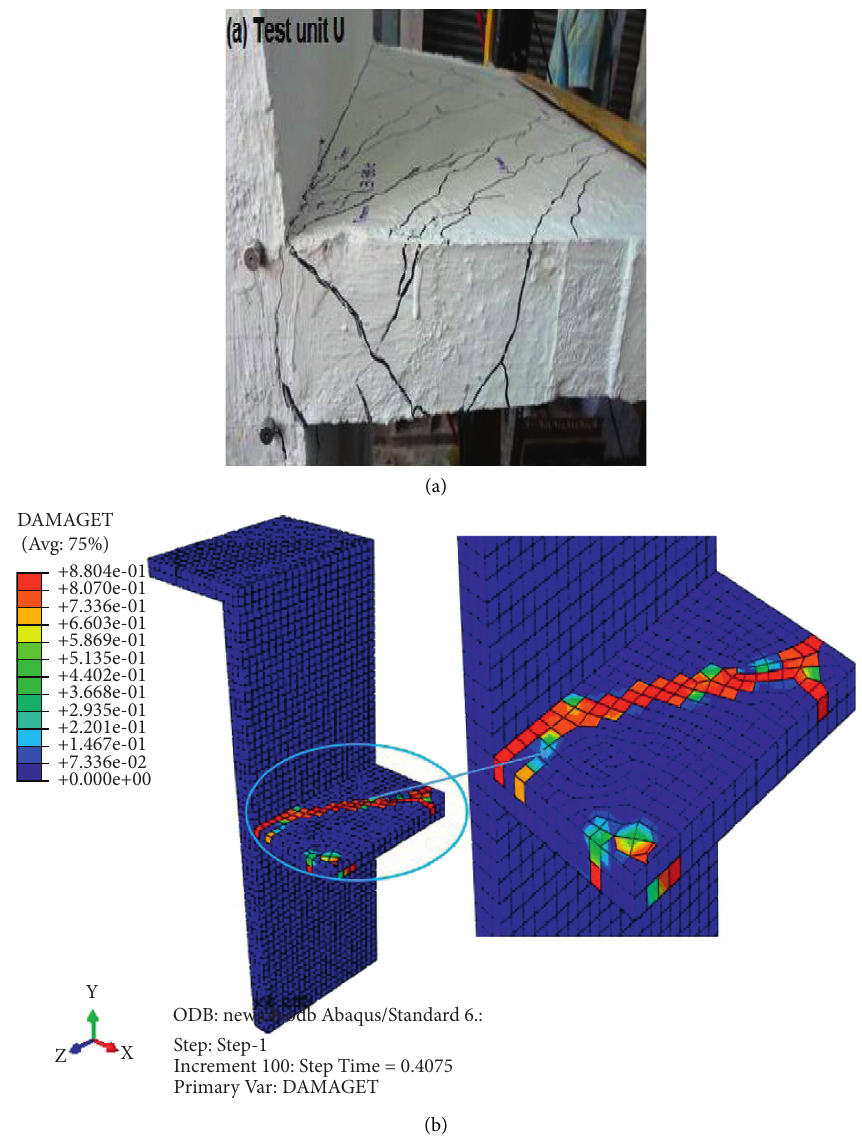
Figure 9: Comparison of damage mode for experimental and FE model